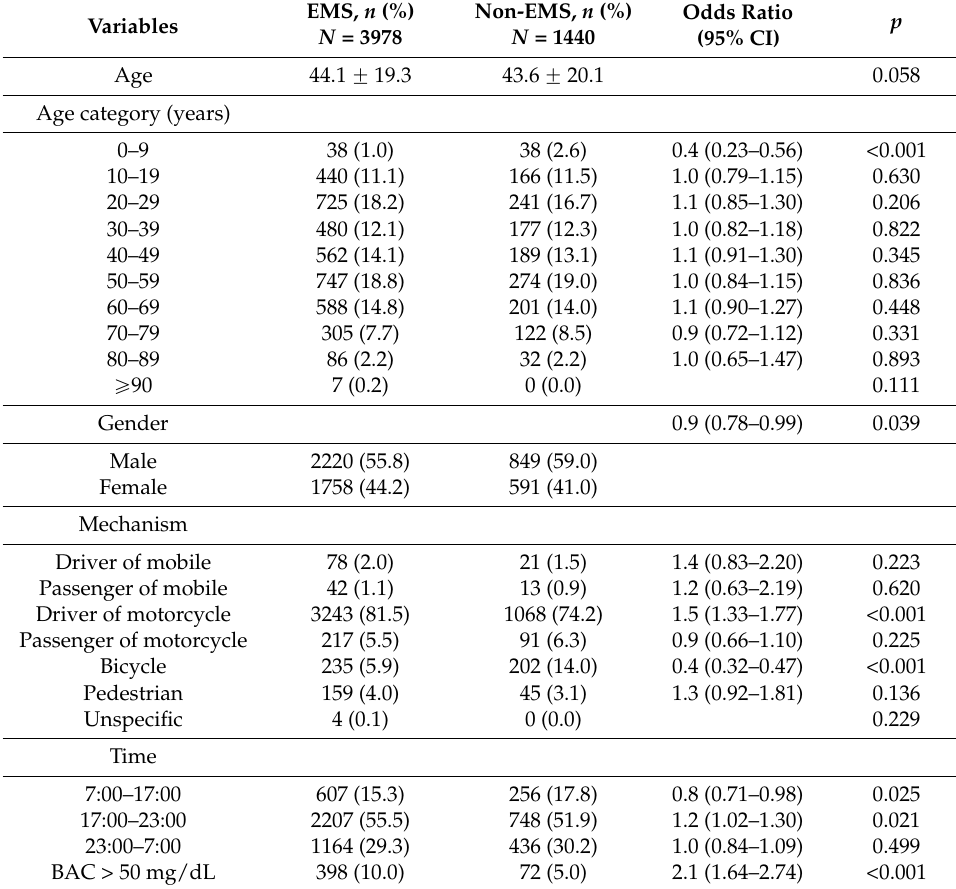
Table 1. Demographics of patients transported by Emergency Medical Services (EMS) and non-EMS.